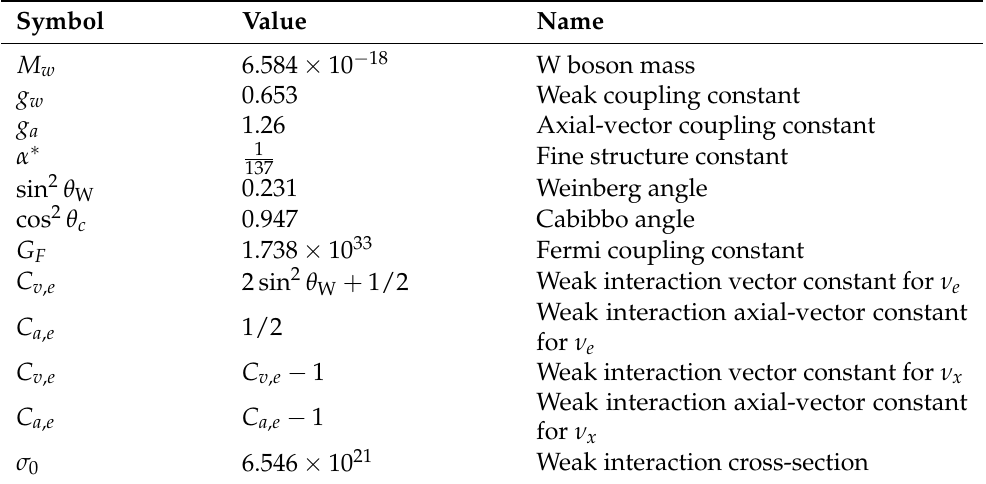
Table A2. Constants used throughout this appendix to calculate emissivities and cross-sections. All quantities are reported in Planck